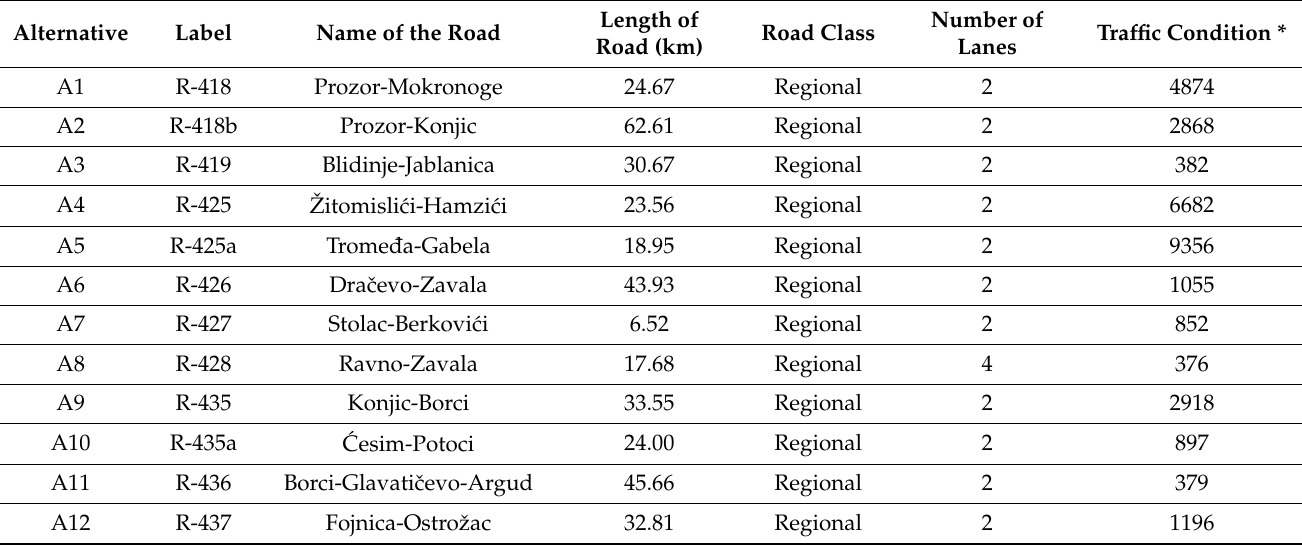
Table 4. Regional road network of Herzegovina-Neretva